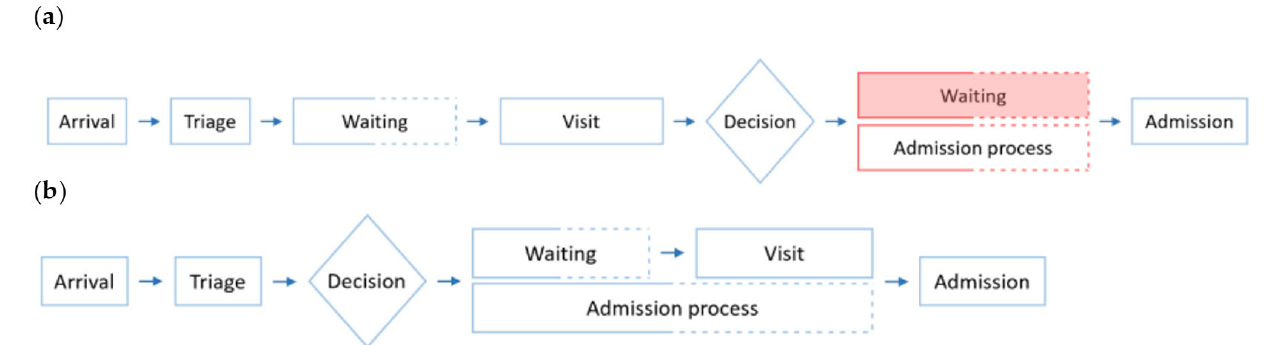
Figure 1. ( a ) Sequential admission model; ( b ) simultaneous admission model.